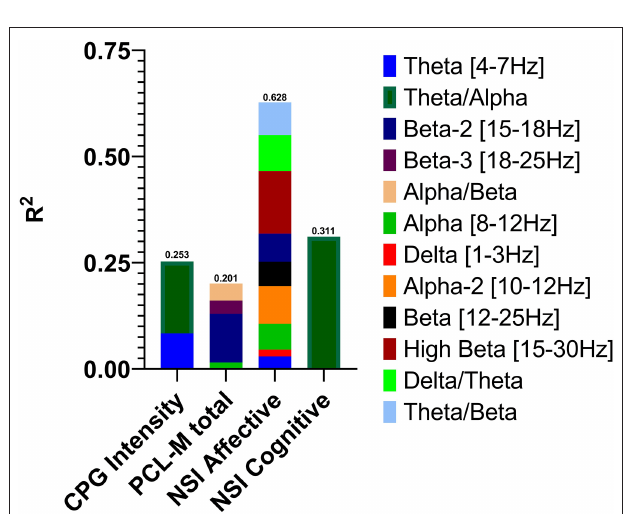
FIGURE 1 | Variance in post-treatment changes in pain intensity, post-traumatic stress symptoms, affective symptoms, and cognitive symptoms accounted for by post-treatment changes in EEG activity in specific frequency bands and power ratios.